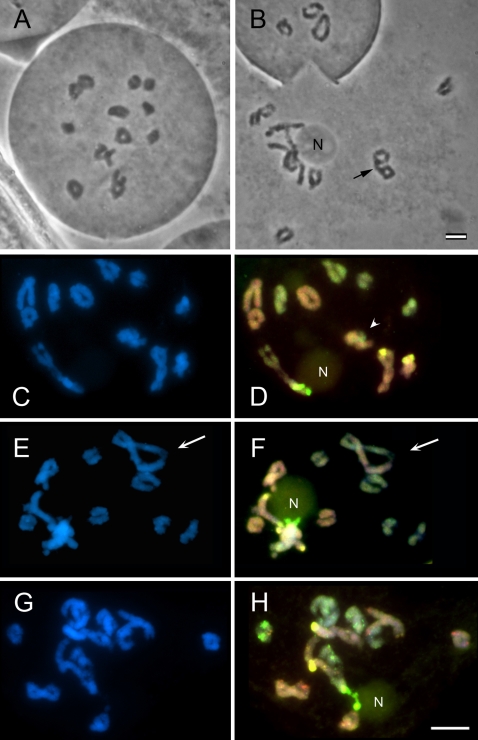
Pollen meiosis in synthetic T. mirus.
(A,B) Feulgen staining showing in (A) 12 regular bivalents and (B) one quadrivalent (arrow) and bivalents in close association with each other and a nucleolus. (C–H). Fluorochrome colours and GISH probes are as in Figure 2. (C–D) Note chromosome Adu in association with the nucleolus. Two bivalents, one from the T. dubius genome (yellow) and one from the T. porrifolius genome (orange), overlapped (arrow), perhaps occurring as a multivalent. (E–F). Note the rDNA and the bivalents carrying these genes associated with the nucleolus. A quadrivalent with two chromosomes of T. dubius origin and two of T. porrifolius origin occurring in a ring (arrow). (G–H) Note two bivalents (Adu and Dpo) with rDNA associated with the nucleolus and the Apo bivalent with condensed rDNA unassociated with the nucleolus. N = nucleolus. Scale bar (C–H) is 10 µm.